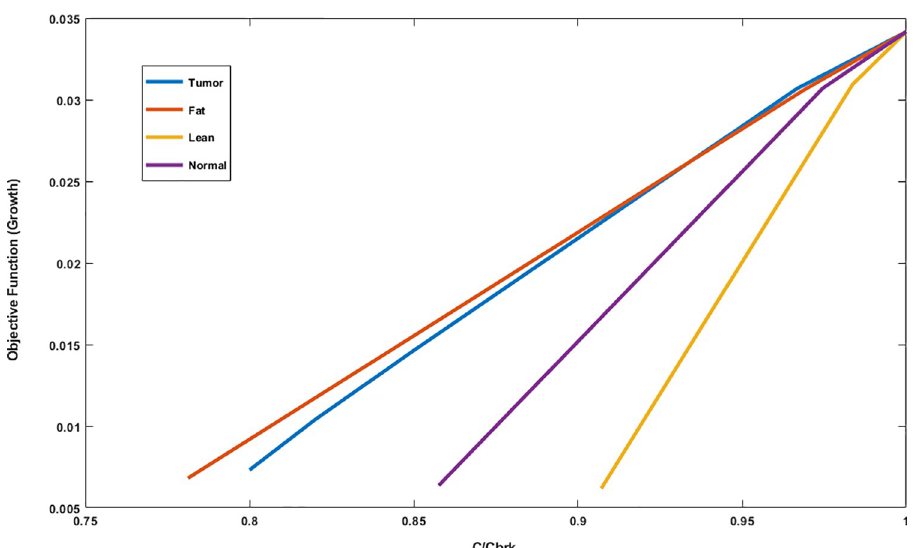
Fig 3. The different patterns of the growth sensitivity to the normalized parameter of TRFBA algorithm (C/C brk ), are a source for differentiation of the four models.